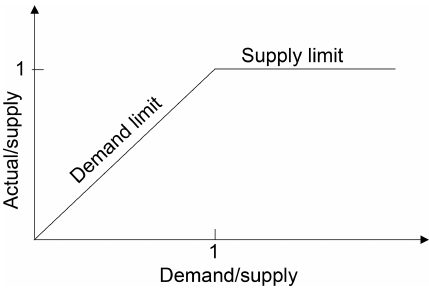
Figure 1. An overview of the Budyko supply and demand frame- work for understanding the land-surface flux response (actual) over natural and human-altered watersheds. The “limits” concept as sug- gested by Budyko (1958) quantifies the actual response ( y axis) based on the physical demand-to-supply ratio of energy / moisture over the control volume or the